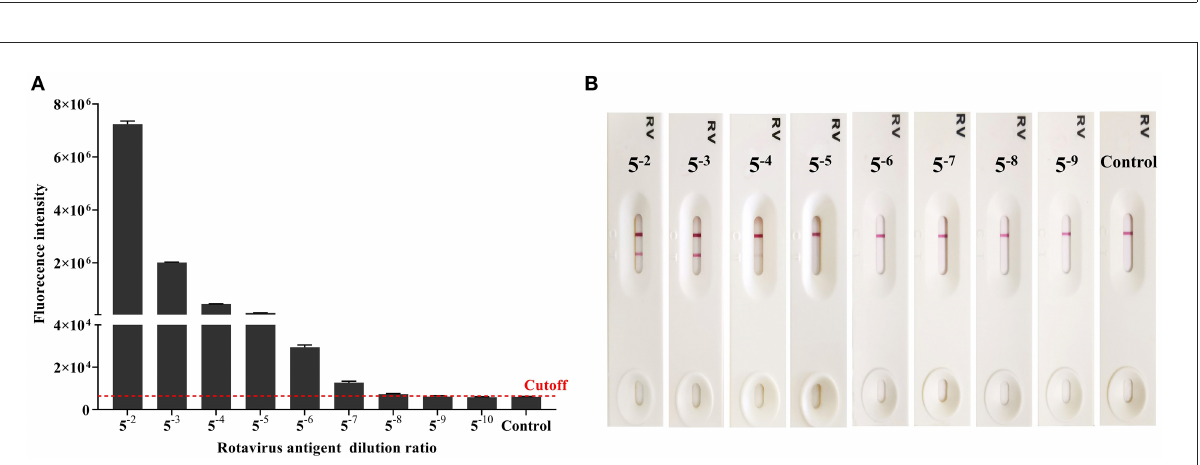
FIGURE2 Comparison of the detection sensitivity for AlphaLISA and ICA (Result of one experiment shown only, see Supplementary Figure 1 for the others). (A) Rotavirus antigen detection using AlphaLISA. Mean values from 3 trials are plotted with error bars denoting the standard deviation; (B) Rotavirus antigen detection using the